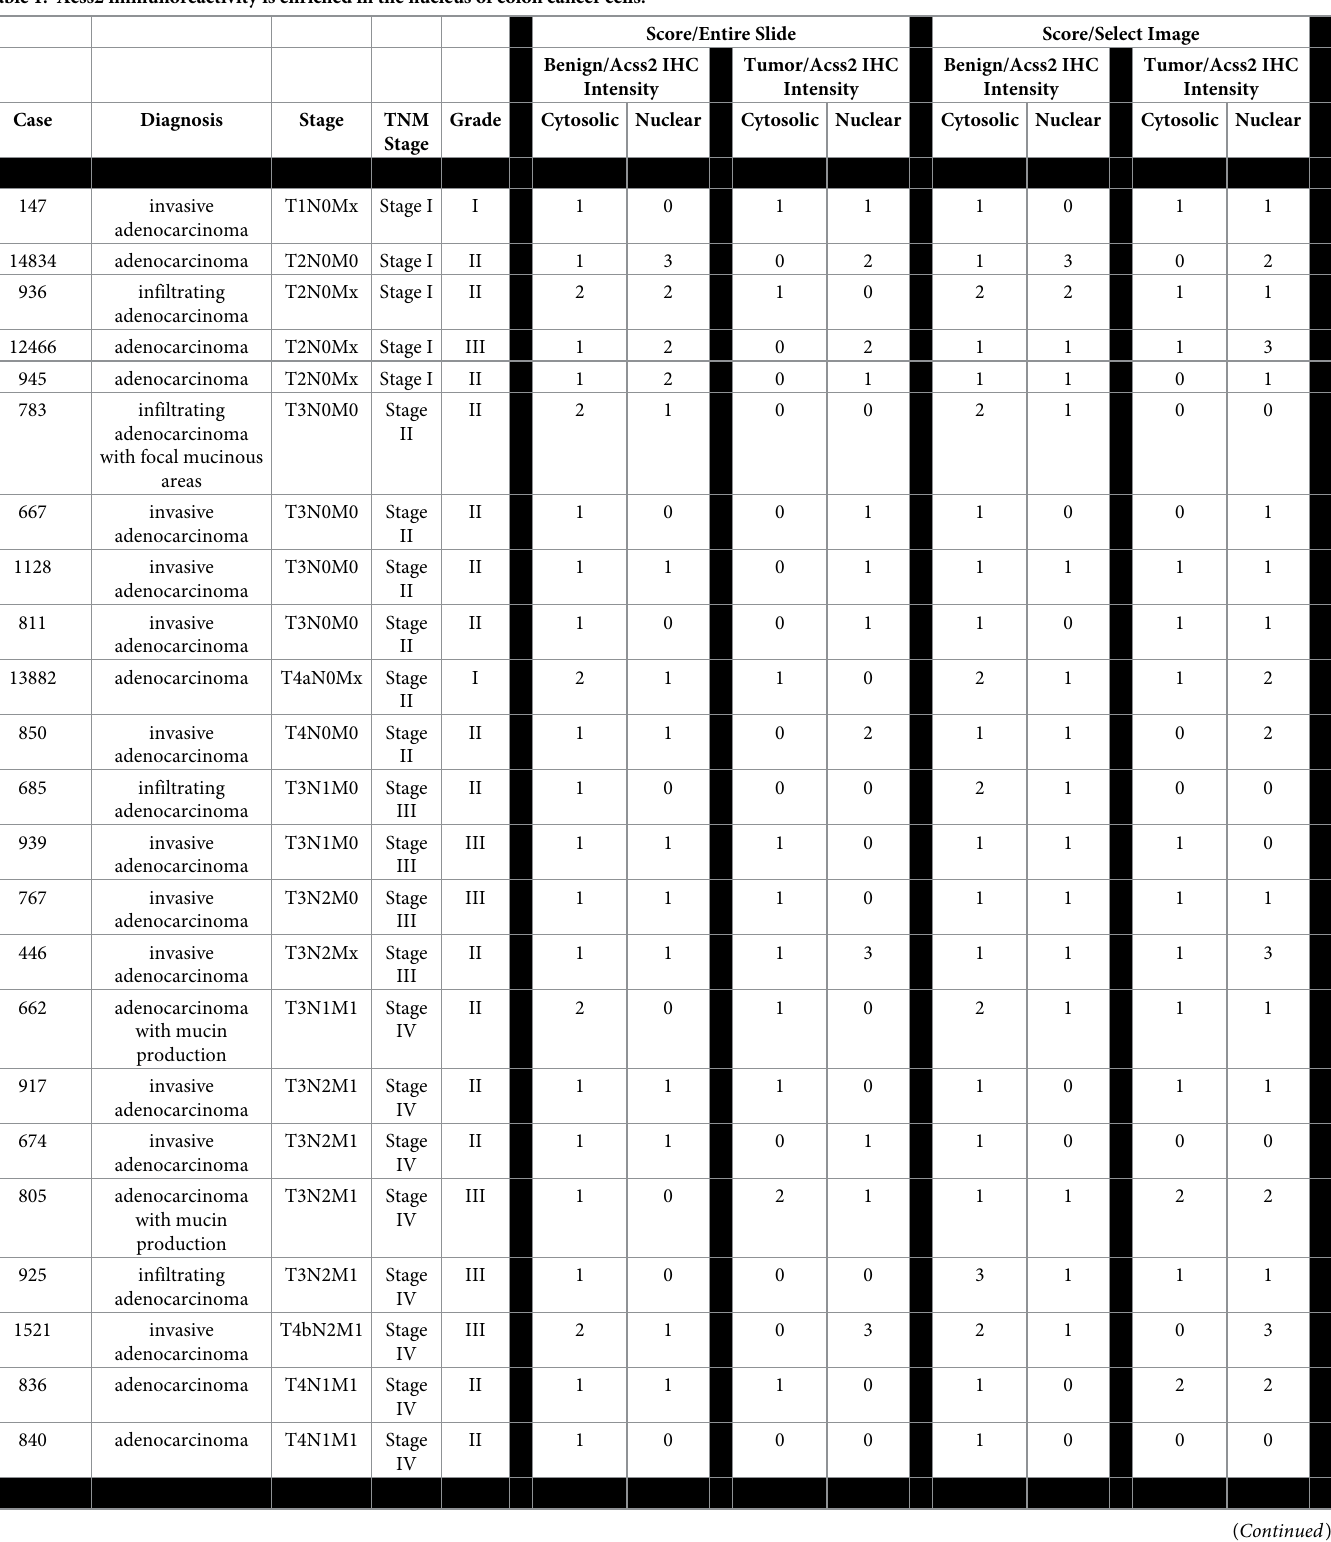
Table 1. Acss2 immunoreactivity is enriched in the nucleus of colon cancer